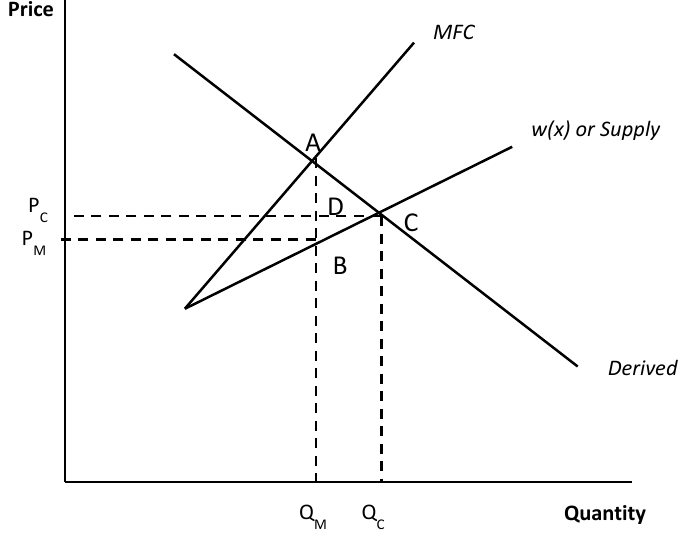
FIGURE 1: Representation of Welfare Effects under a Monopsony Market Structure Source: ABA